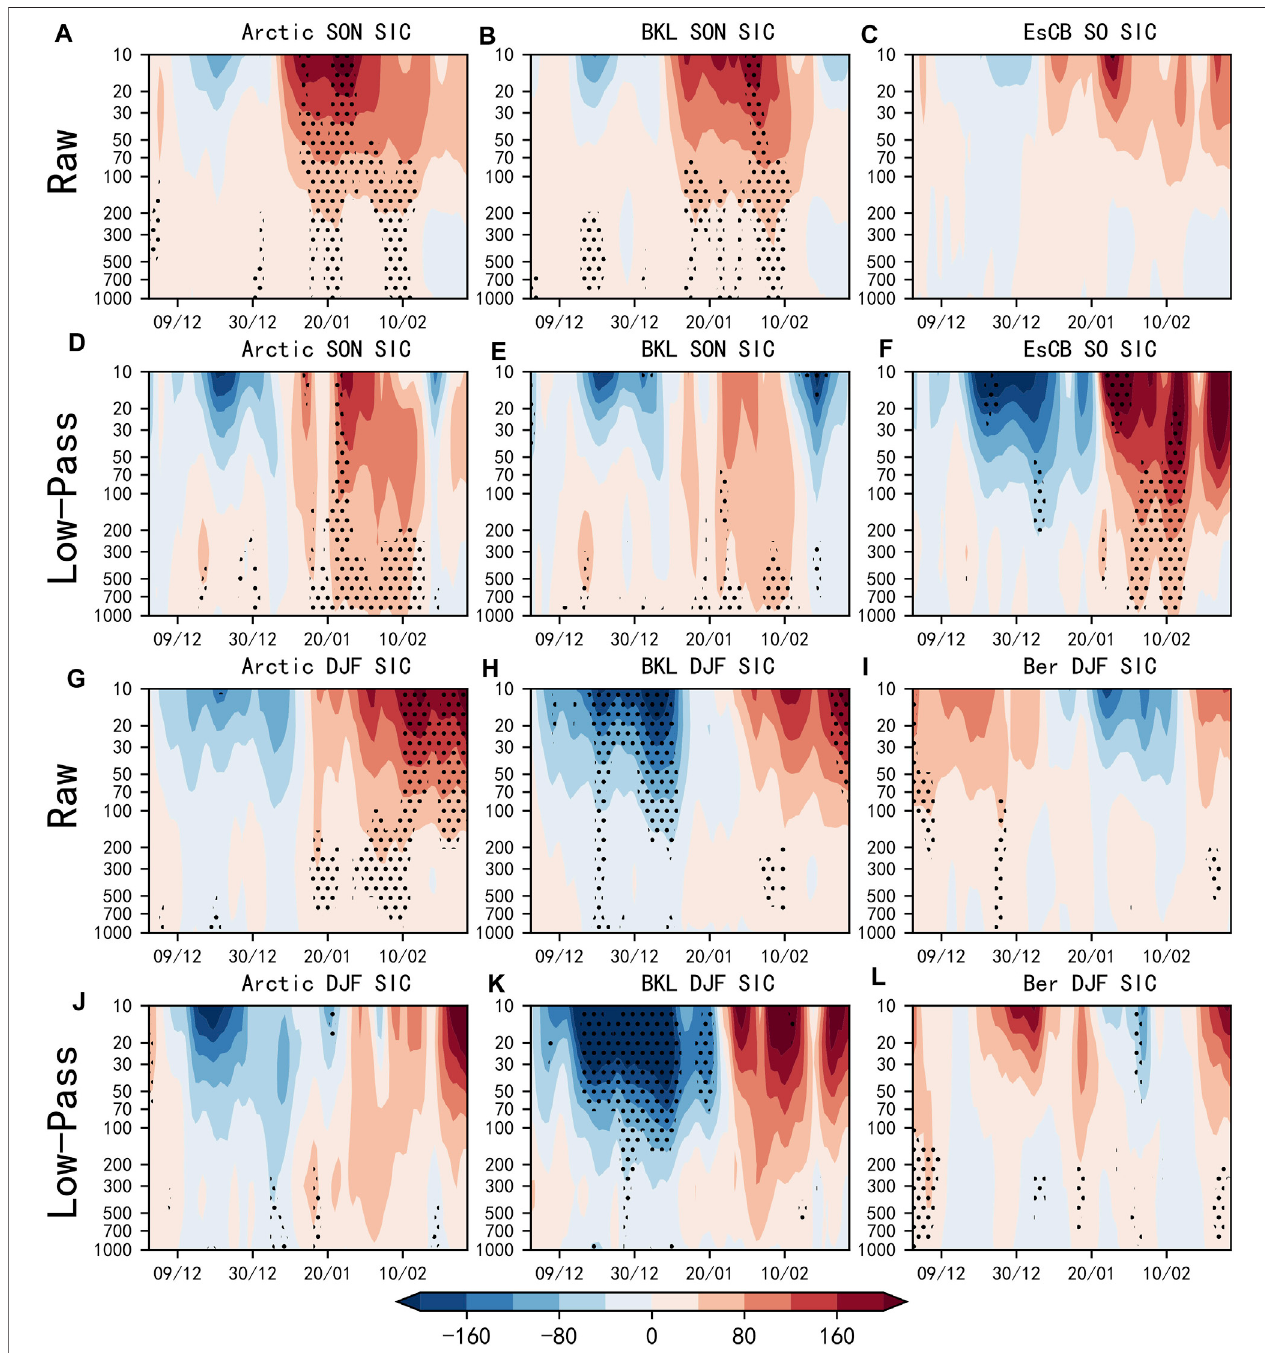
FIGURE 5 | As in Figure 3 but for the winter daily evolution of polar cap height (PCH; 70 ° – 90 ° N; unit: m).